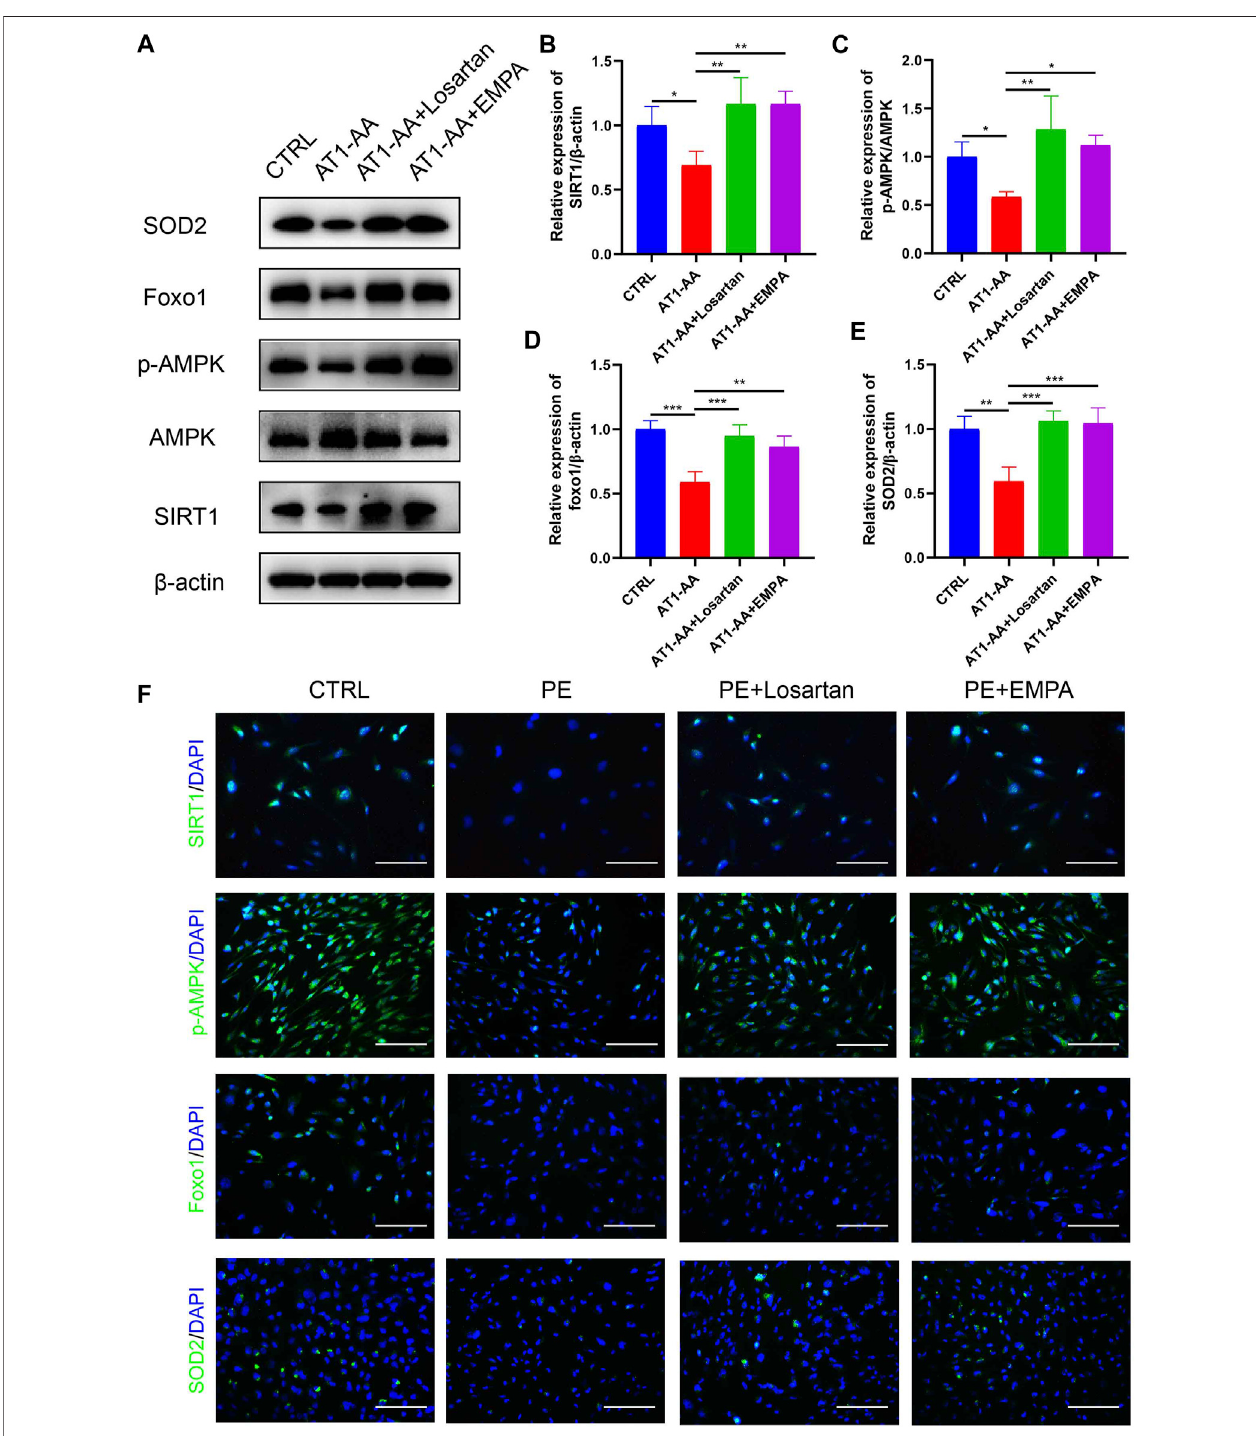
FIGURE 6 | Effects of EMPA on AMPK/SIRT1 and oxidative stress in cultured human podocytes. (A) Protein levels of SIRT1, AMPK, p-AMPK, Foxo1 and SOD2 in podocytes determined by Western blot analysis. (B) Densitometric evaluation of Western blots for SIRT1 ( n = 3), (C) p-AMPK ( n = 3), (D) Foxo1 ( n = 3) and (E) SOD2( n =3). (F) Representativeimmuno fl uorescenceimagesofSIRT1,p-AMPK,Foxo1andSOD2inpodocytes.Scalebar:100 μ m.Dataareexpressedasthe mean ± SEM and were analyzed by ANOVA with LSD post hoc test. * p < 0.05, ** p < 0.01, *** p < 0.001.